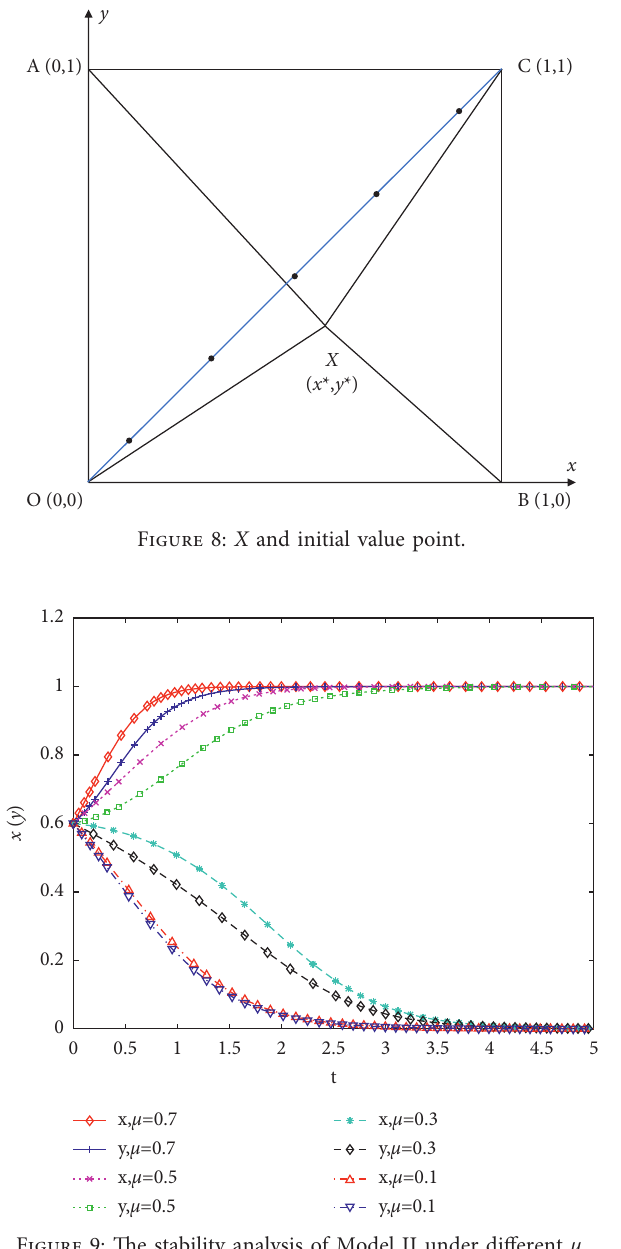
Figure 9: The stability analysis of Model II under different μ